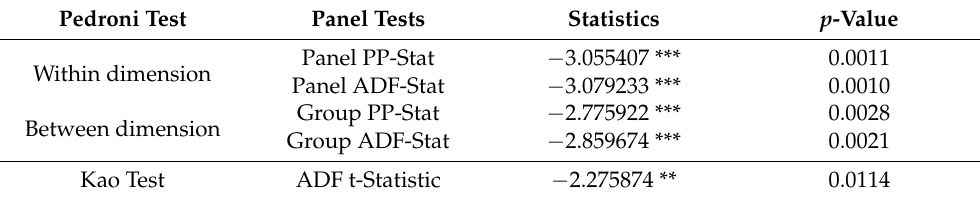
Table 5. Panel co-integration testing